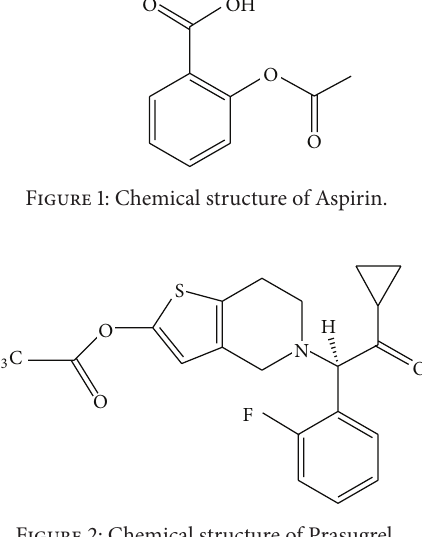
Figure 2: Chemical structure of